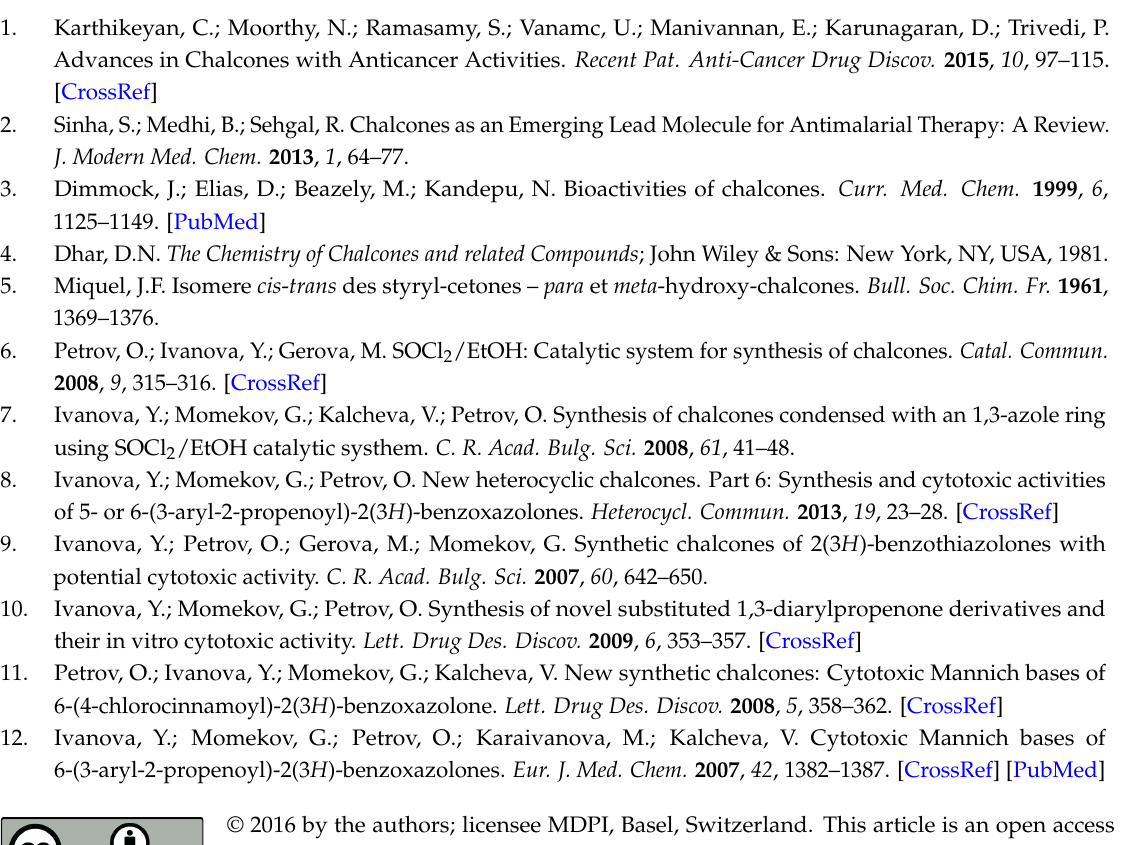
Supplementary Materials: 1 H-, 13 C-NMR and MS spectra for compound 3 are available online at